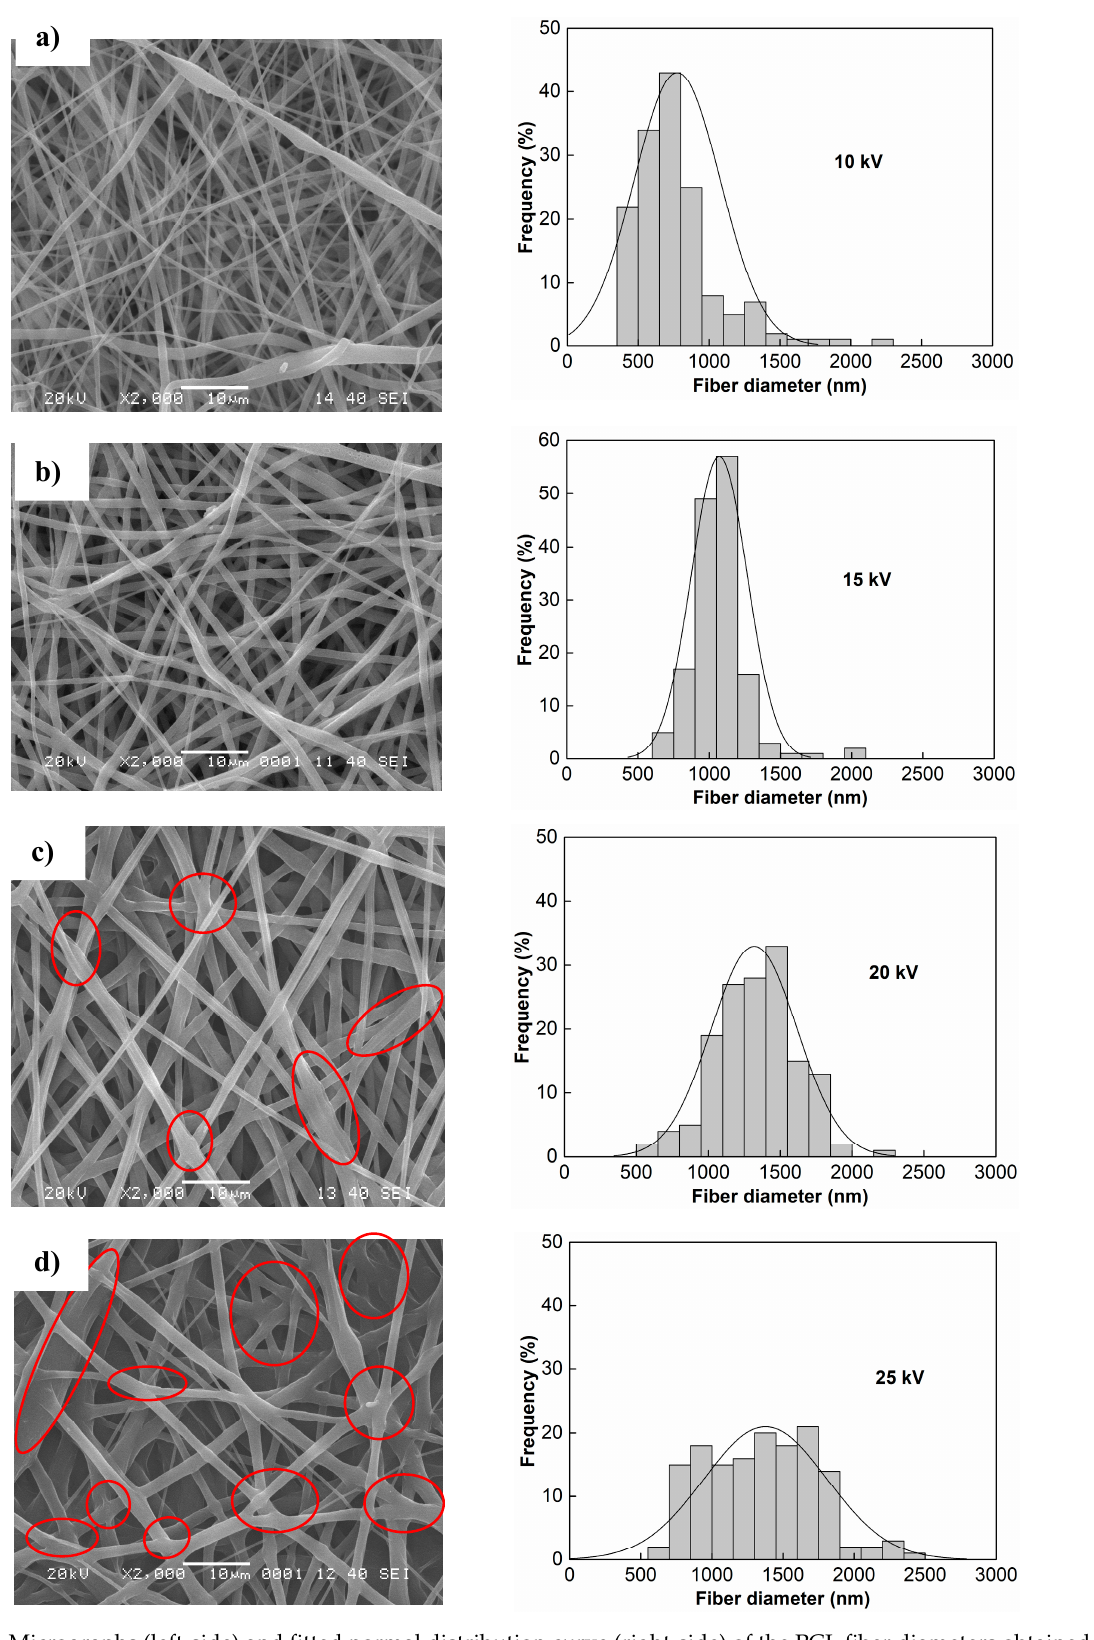
Figure 2. Micrographs (left-side) and fitted normal distribution curve (right-side) of the PCL fiber diameters obtained at applied voltages: ( a ) 10 kV, ( b ) 15 kV, ( c ) 20 kV, and ( d ) 25 kV.